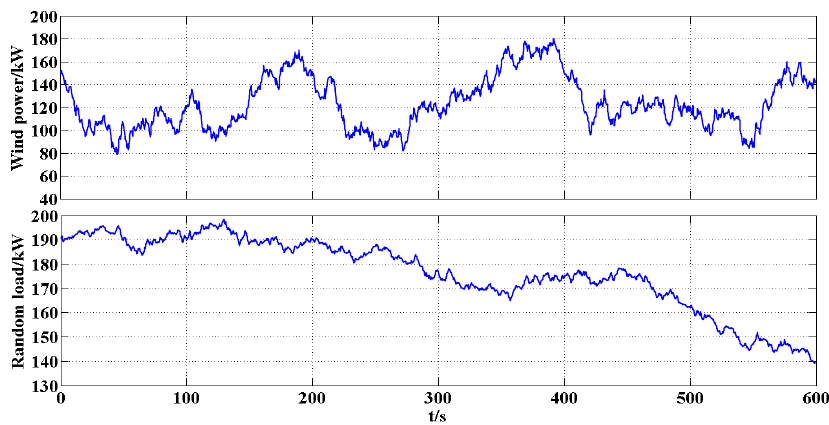
Figure 11. Wind power and random load for case